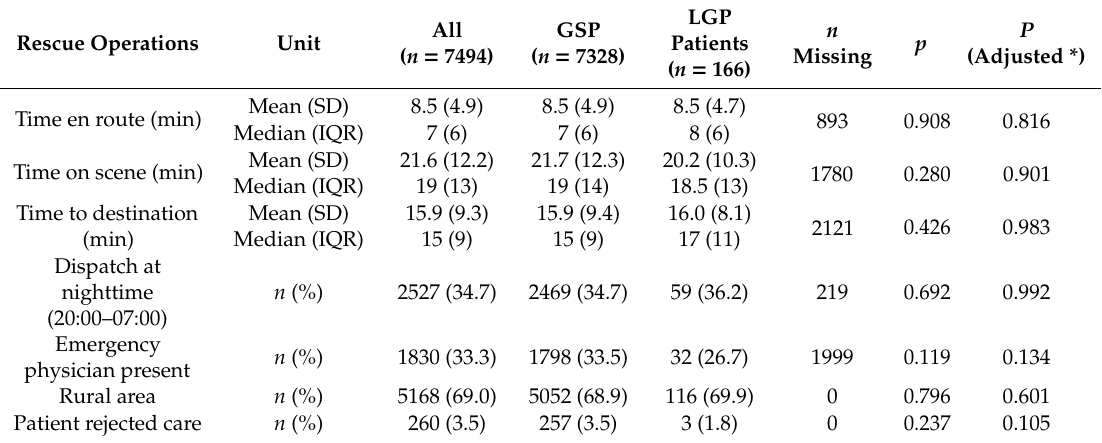
Table 2. Characteristics of rescue operation.